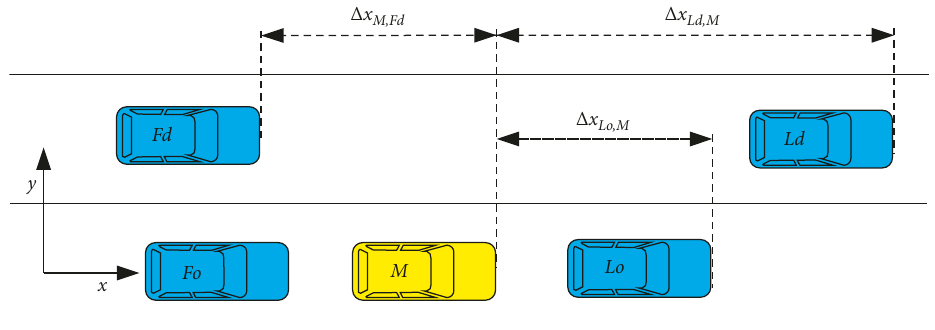
Figure 1: Pre-lane-changing configuration showing position of the involved vehicles.